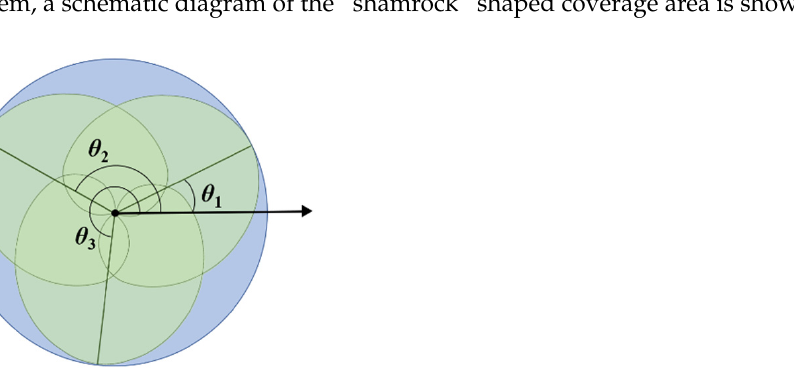
with polar coordinates. The light blue circle area represents the traditional circular coverage area. The “shamrock” shaped coverage area is colored in light green. Different lines indicate